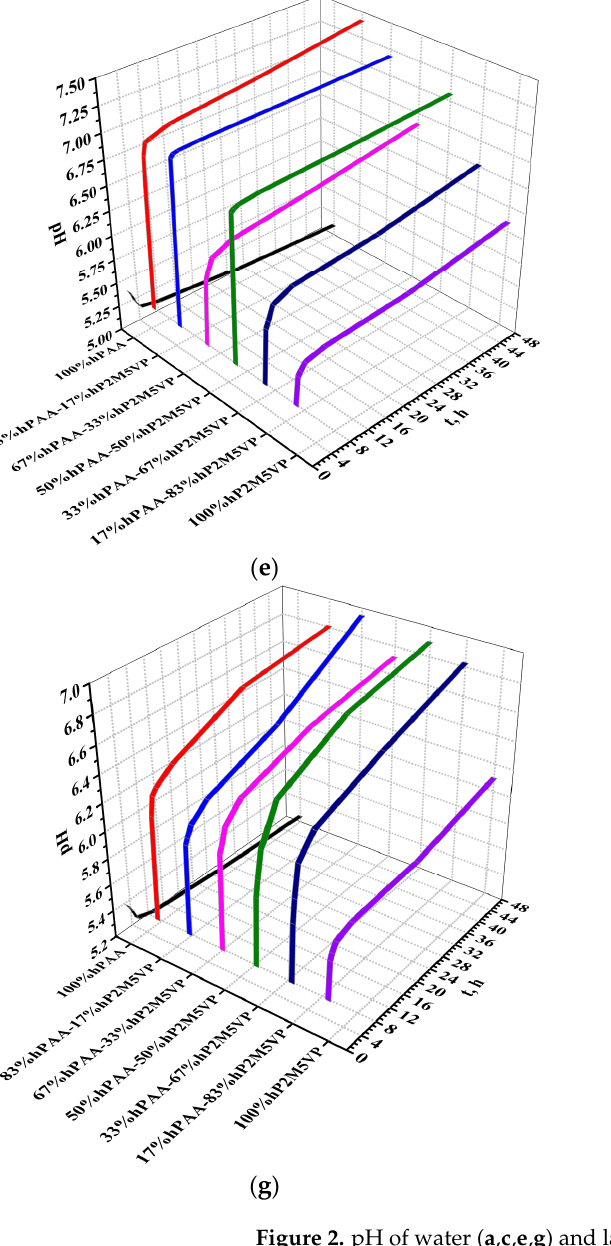
Figure 2. pH of water ( a , c , e , g ) and lanthanum nitrate ( b , d , f , h ) in presence of interpolymer sys-